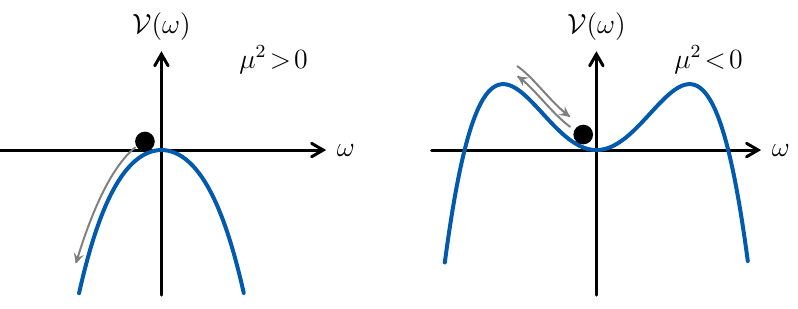
Figure 1 . Illustration of the upside-down potential